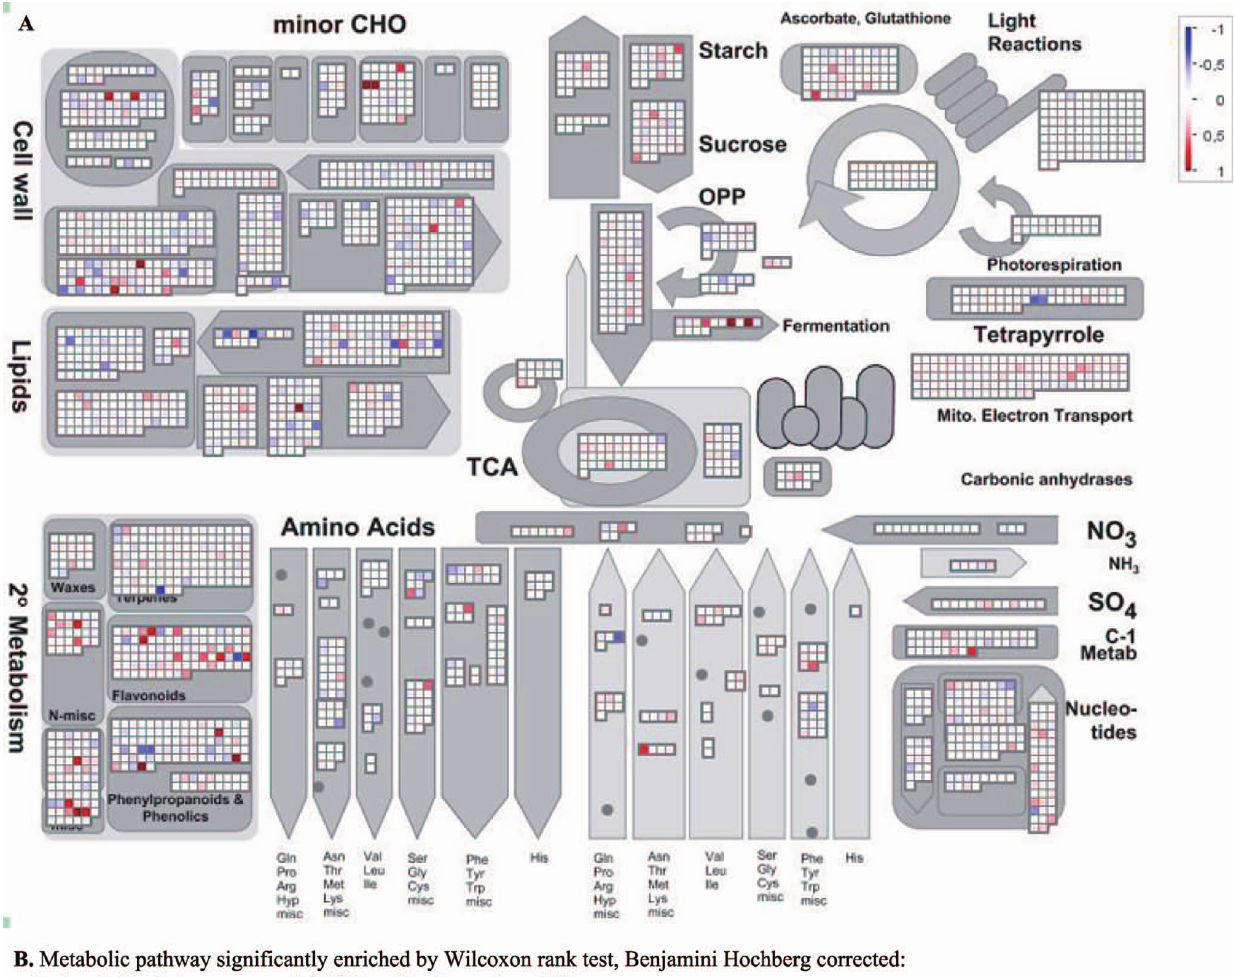
Figure 7. MAPMAN metabolic overview of transcriptional changes day4. Shown are the overall gene expression changes related to the metabolism day4 between 3MB treated leaves 2 and controls. The Wilcoxon rank sum, with Benjamini-Hochberg correction, is shown below.